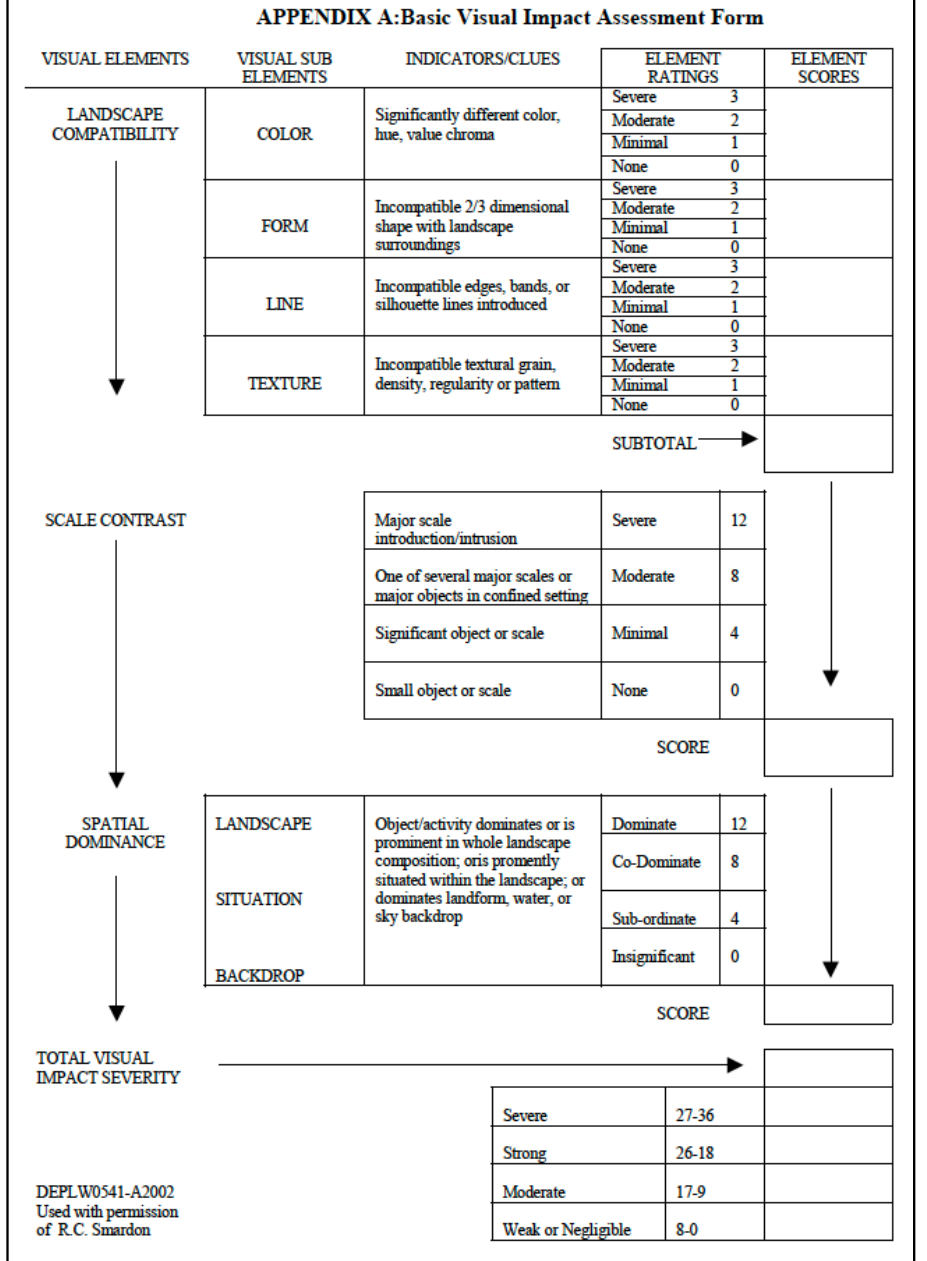
Figure 2. The contrast rating form used by the Maine Department of Environmental Protection. Source: [19].